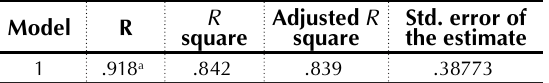
Table 11. Model summary